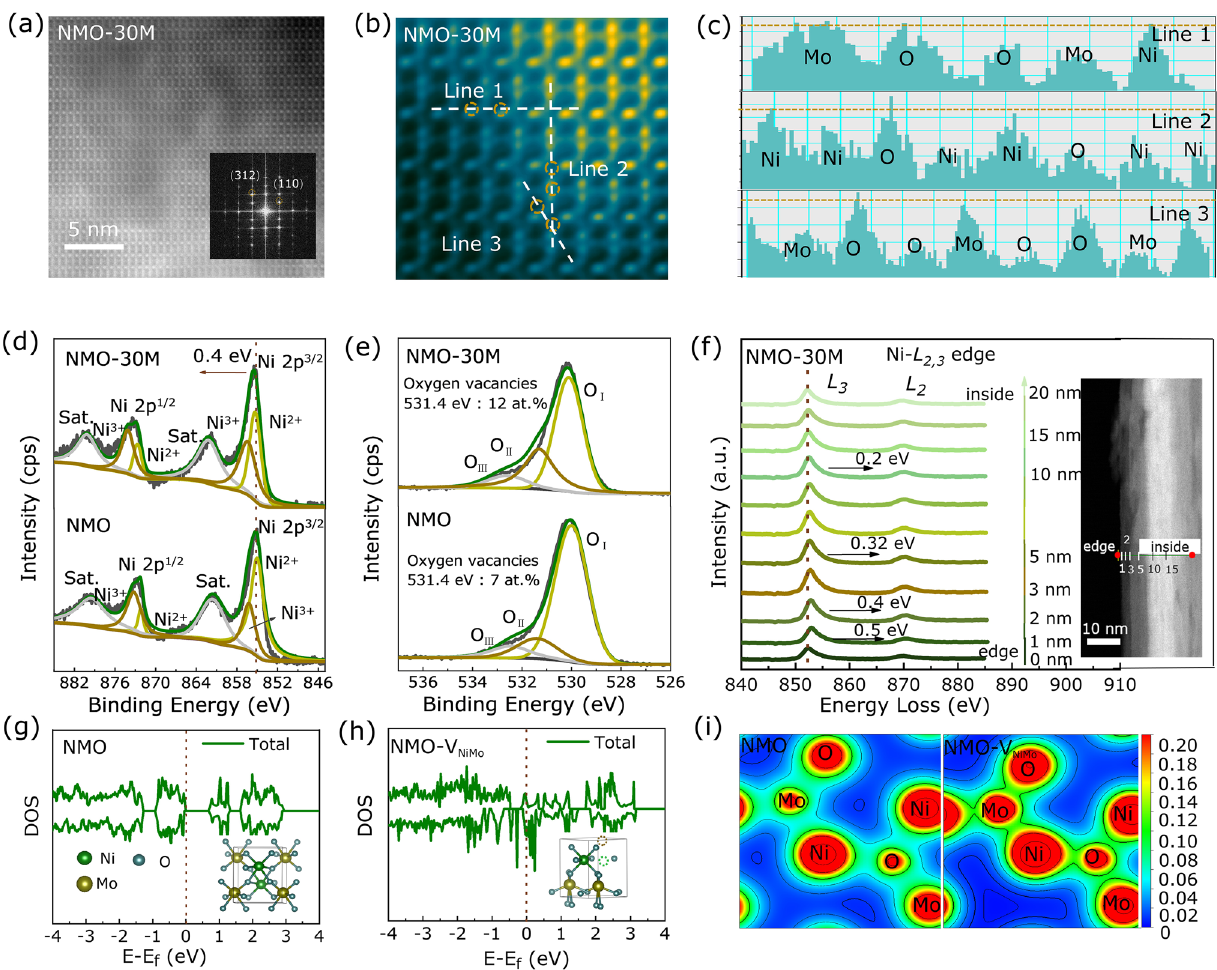
Fig. 2 Electronic structure analysis based on experimental results and theoretical calculation. a Original and b colored HAADF-STEM image and of NMO-30M. The fast Fourier transform (FFT)-filtered atomic resolution image is shown in the inset of a . c Corresponding intensity pro- files of line section. High-resolution XPS spectra of d Ni 2 p and e O 1 s for NMO and NMO-30M. f Ni L -edge EELS spectra among different regions (STEM image) throughout etching. DOS of g pristine NMO and h NMO-V NiMo . i The charge density diagram of NMO and NMO-V